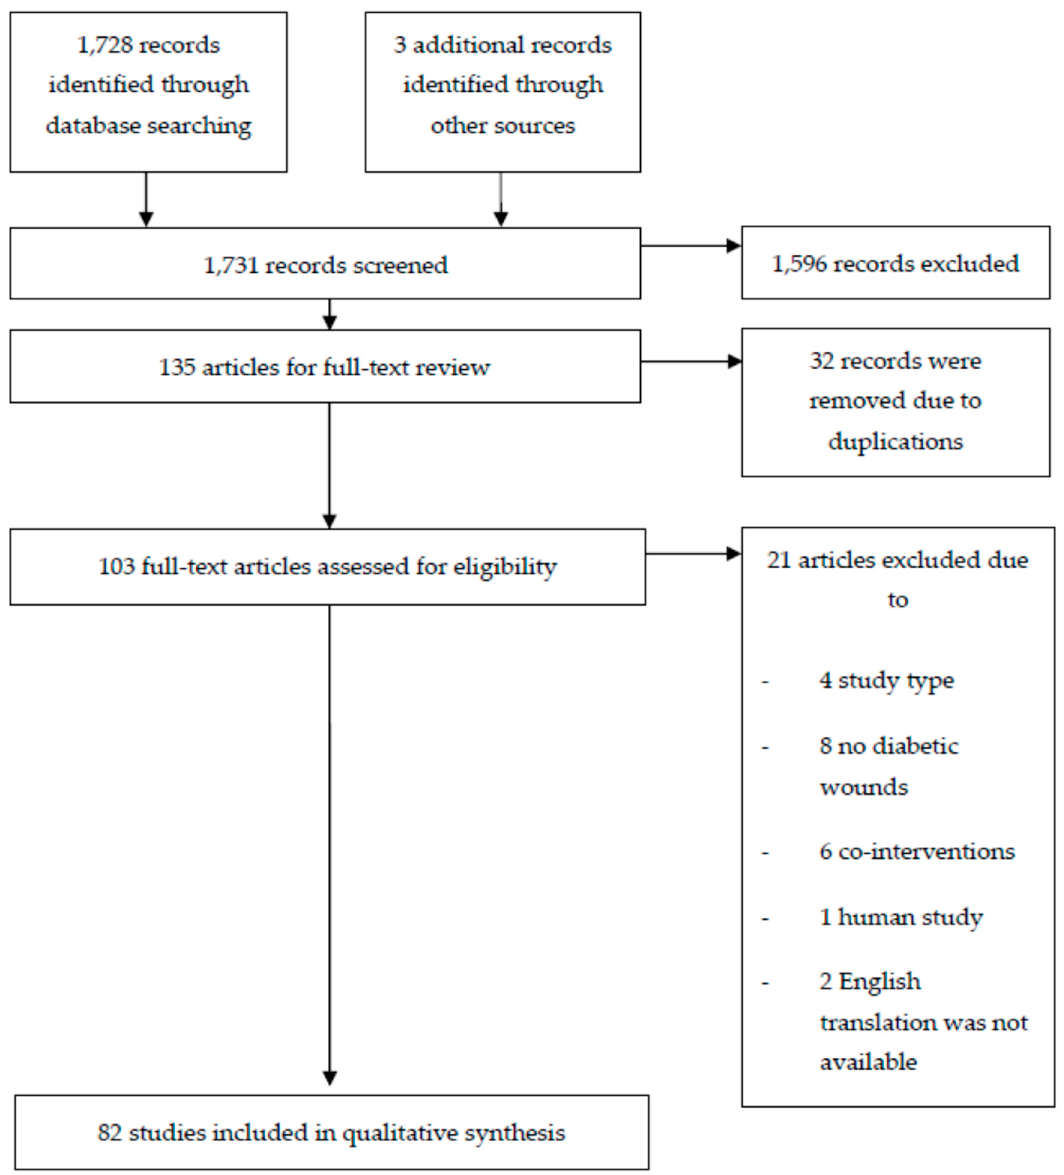
Figure 1. Systematic reviews flow diagram of the selected BPEs literature search.